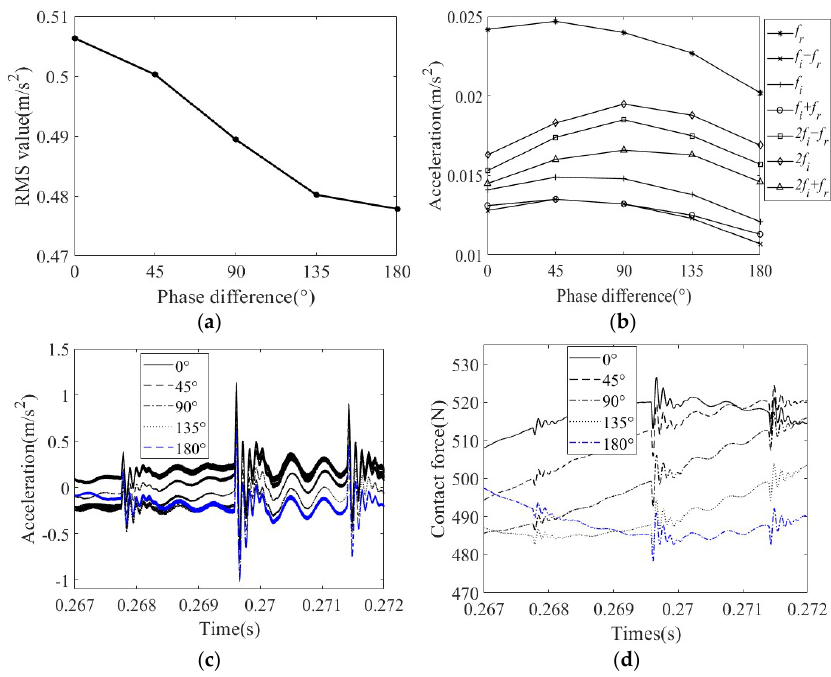
Figure 14. The vibration characteristics of the bearing under inner ring defect and unbalanced force: ( a ) RMS; ( b ) amplitudes of f r , f i − f r , f i , f i + f r , 2 f i − f r , 2 f i , 2 f i + f r ; ( c ) housing acceleration signal from 0.267 s to 0.272 s; ( d ) contact force between outer ring and housing from 0.267 s to 0.272 s.